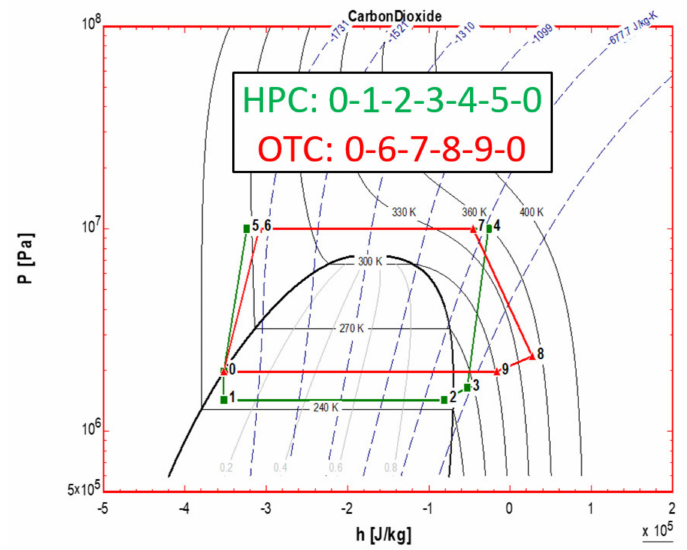
Figure 3. Zoom on the CO 2 P-h